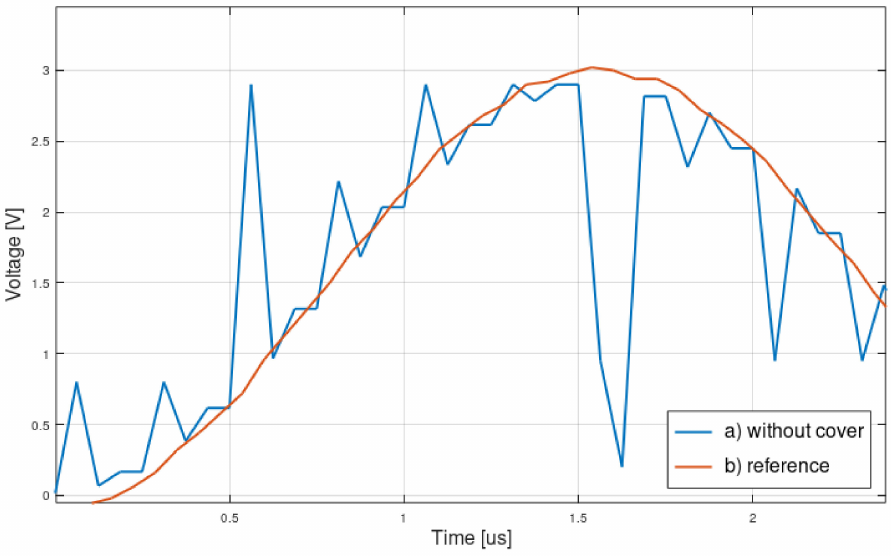
Figure 9. Noise in the sinusoidal waveform for unshielded measurements in relation to an oscilloscope. Periodic disturbances are clearly visible in the sine wave. On the rising edge, they have a positive component (amplitude gain) and for the falling edge they have a negative component (they reduce the signal) as shown in Figure 9. The measurements were made for the maximum sampling frequency and sinusoidal signal with a frequency of 300